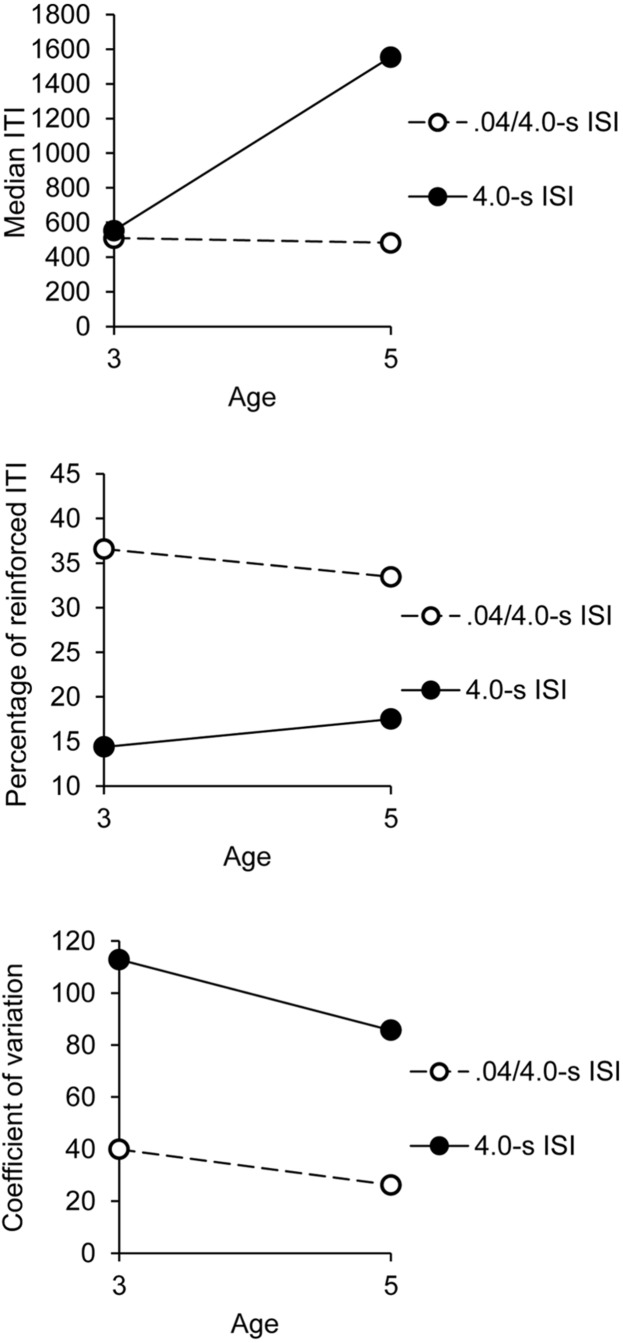
Pre- and post-synchronization phases (averaged): indexes of performance as a function of age and group.